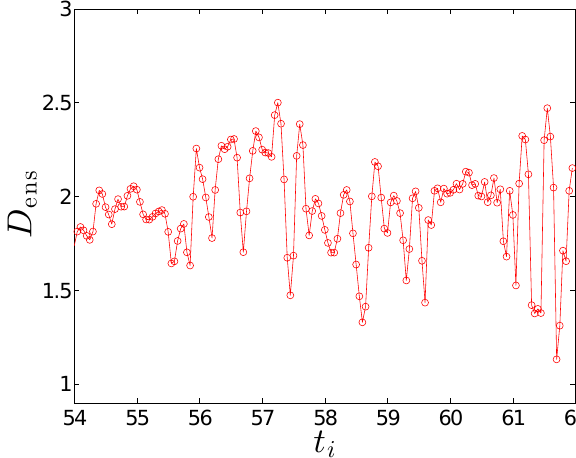
Fig. 5. Ensemble dimension D ens as a function of analyses cycles. Parameters as in Fig.